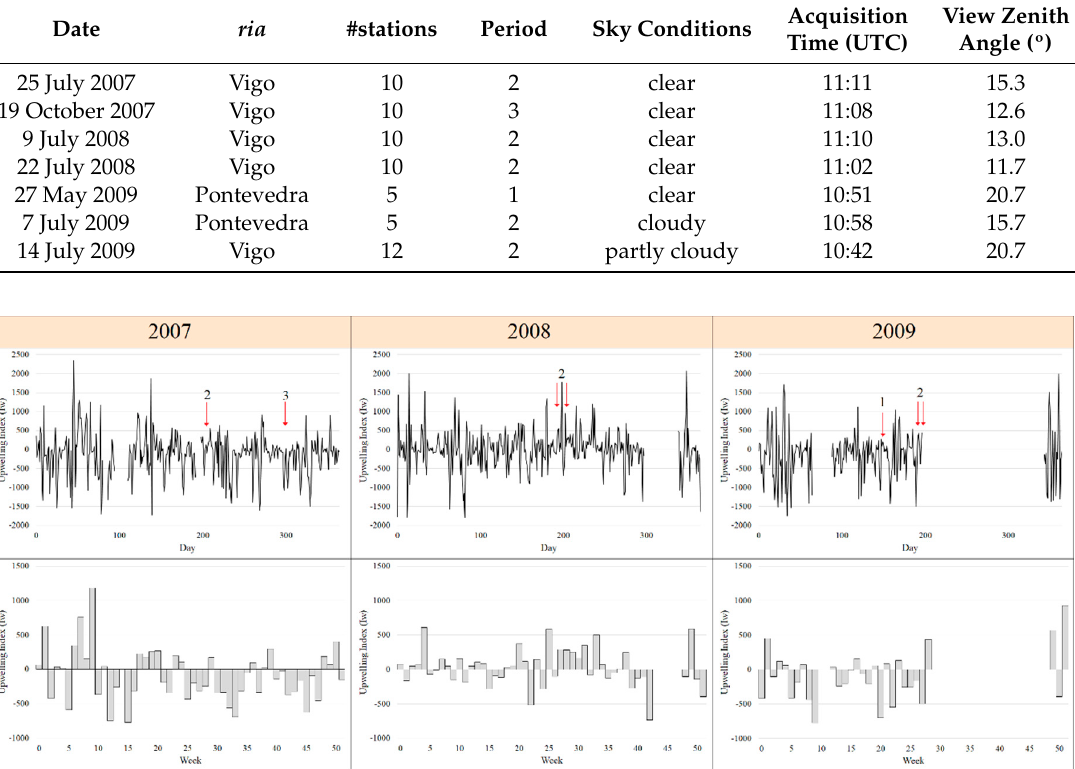
Figure 2. Daily and weekly upwelling index off the rias Baixas for the years 2007–2009. The Iw in m − 3 s − 1 100 m − 1 represents the offshore Ekman flux in the surface layer. Arrows indicate the days where the in-situ surveys were carried out.